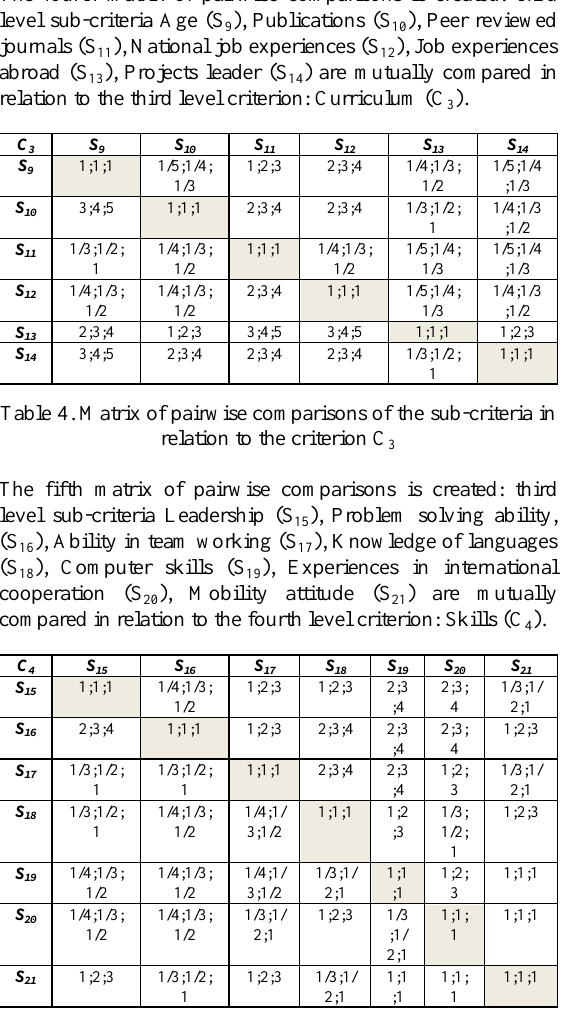
Table 5. Matrix of pairwise comparisons of the sub-criteria in relation to the criterion C 4